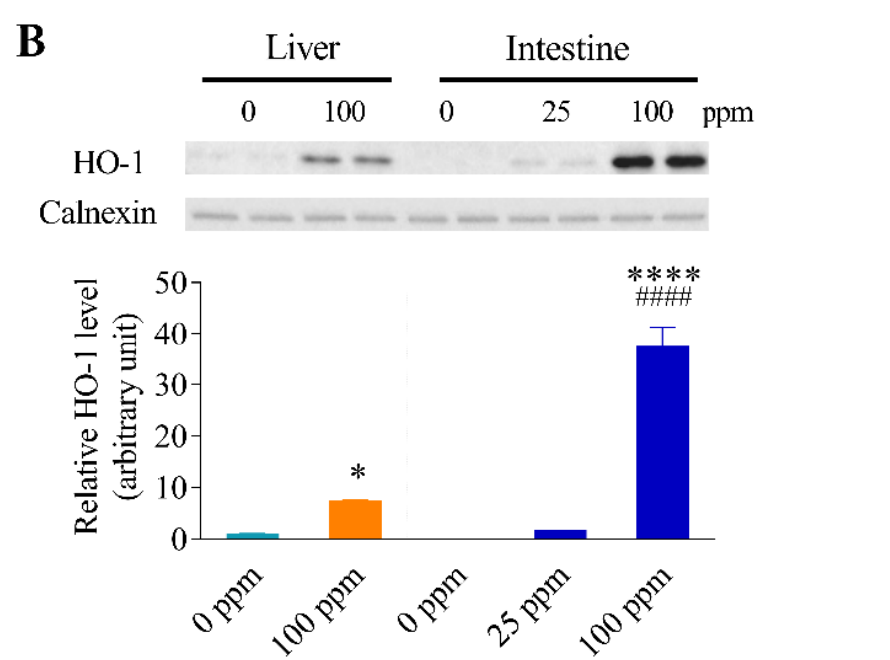
Figure 6. Differential inducibility of hepatic and intestinal HO-1 expression at a higher arsenic dose. Relative HO-1 mRNA ( A ) and protein ( B ) levels were determined for the liver and small intestinal epithelial cells of male, 3–4-month-old mice, after 28 days of arsenic exposure via drinking water. Mice given drinking water alone (0 ppm) were used as control. ( A ). HO-1 mRNA levels determined by RT-PCR. Data represent means ± SD of individual mice analyzed, and were normalized to GAPDH levels; *, p < 0.05, 100-ppm ( n = 4) vs. corresponding 0-ppm control ( n = 2), unpaired t-test, two-tailed. ( B ). HO-1 protein levels determined by immunoblot analysis. Microsomes were prepared from pooled liver or small intestinal epithelial cells of three mice per group. Each lane con- tained 5 µg of total protein. Samples were analyzed in duplicates. Densitometry data (means ± SD of duplicate determinations) were normalized by calnexin level in each sample and the average level in the 0-ppm liver sample was set to 1.0. *, p < 0.05, ****, p < 0.0001, vs. corresponding 0-ppm group; #### , p < 0.0001, vs. liver 100-ppm group (one- way ANOVA followed by Sidak’s multiple comparisons